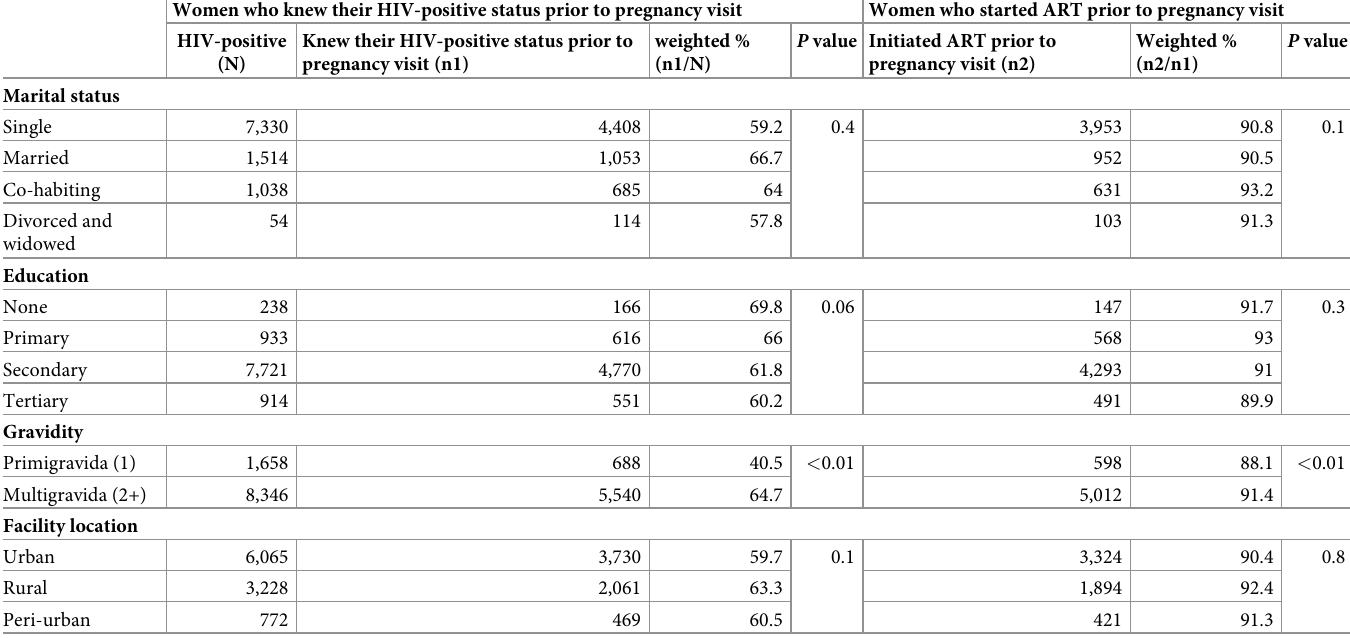
Missing data excluded; ART–Antiretroviral therapy. Univariable models for marital status, population group, education and facility location were adjusted for Age and gravidity. Population group was excluded from the logistic regression, as most (97.1%) participants were Black